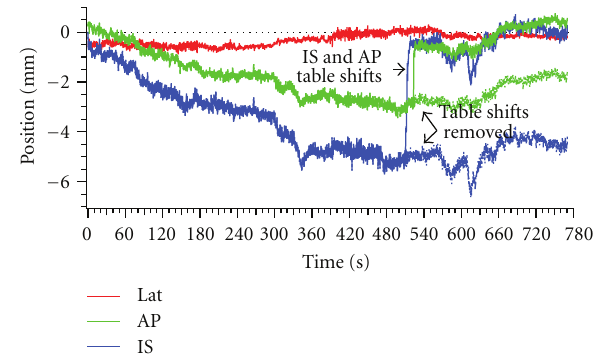
Figure 1: Successive table shifts toward isocenter were present in 8.2% of the measured fraction, such as those seen here in the IS and AP directions. Table shifts were removed to reduce the bias toward isocenter in measured prostate